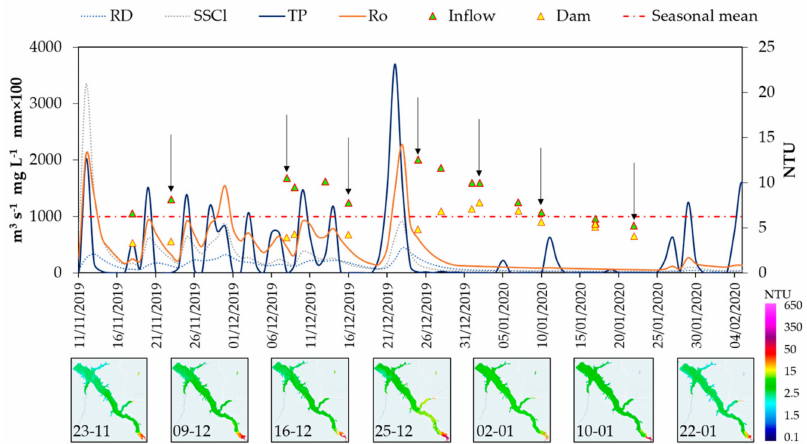
Figure 7. Timeseries of RD, SSCl, TP, and Ro, with Turb values at inflow (green triangles) and dam (yellow triangles) virtual stations. Black arrows indicate the dates for which the relative Turb map is shown. The red dotted line represents the Turb autumn–winter seasonal mean averaged over the 5-year period. Note that TP and Ro are expressed in mm × 100 to have a better